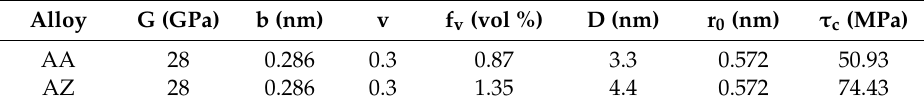
Table 9. Value of parameters of Equation (4) and τ c of alloy AA and AZ at peak aged state.